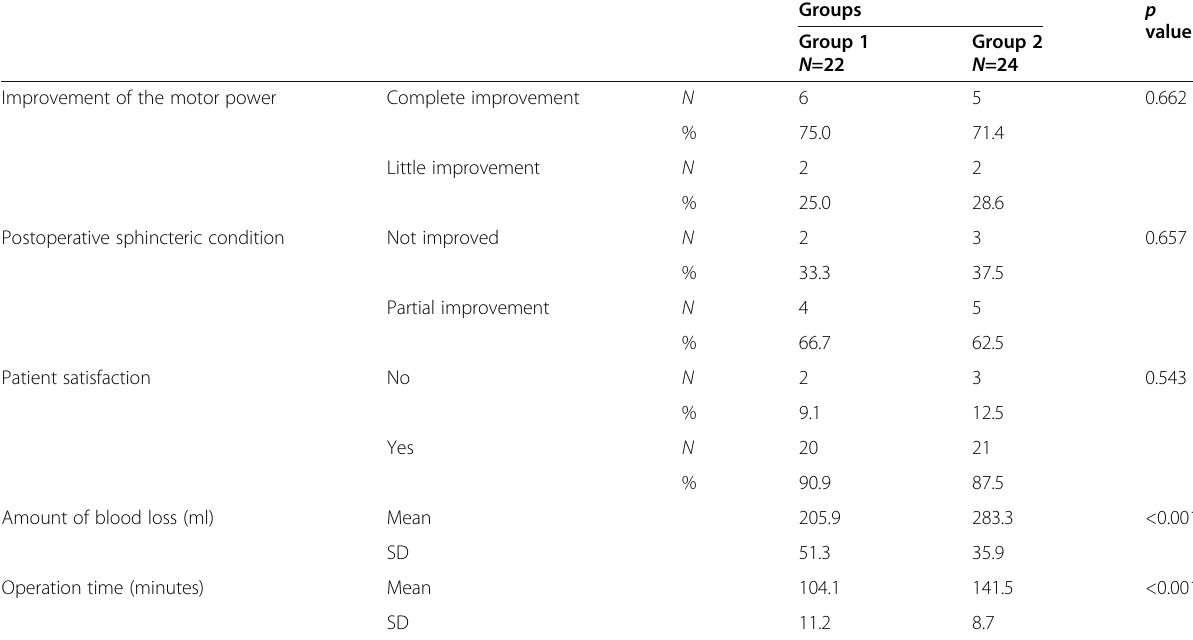
Table 3 Comparison between the studied groups as regards improvement of the motor power, postoperative sphincteric condition, patients ’ satisfaction, amount of blood loss, and operation time